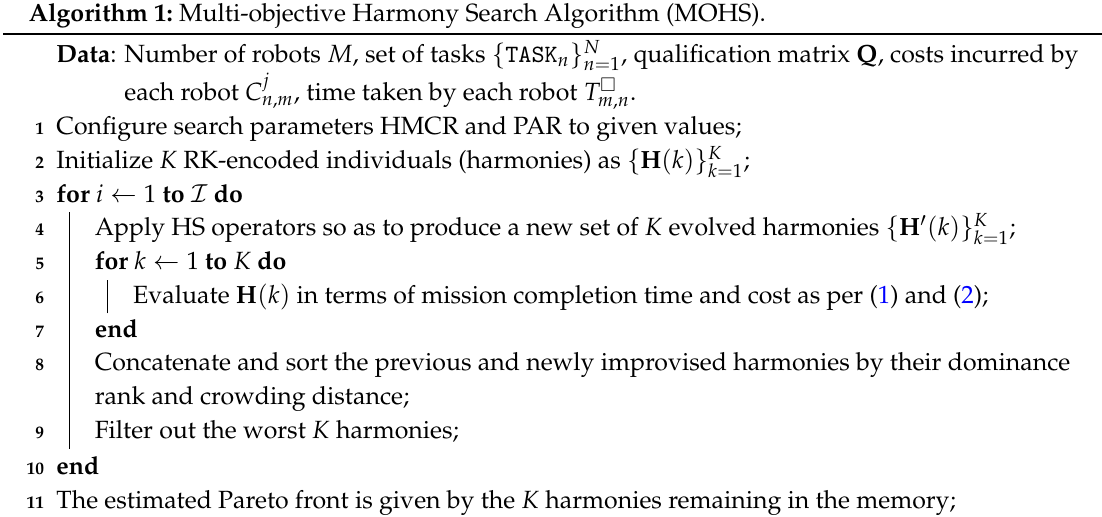
Algorithm 1: Multi-objective Harmony Search Algorithm